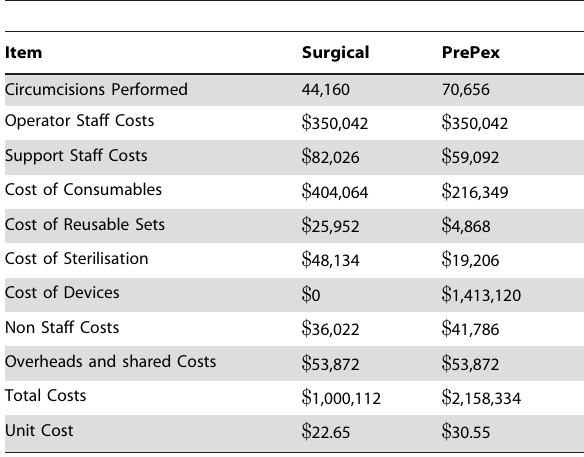
Table 1. Cost model at a high volume SMC urban site at